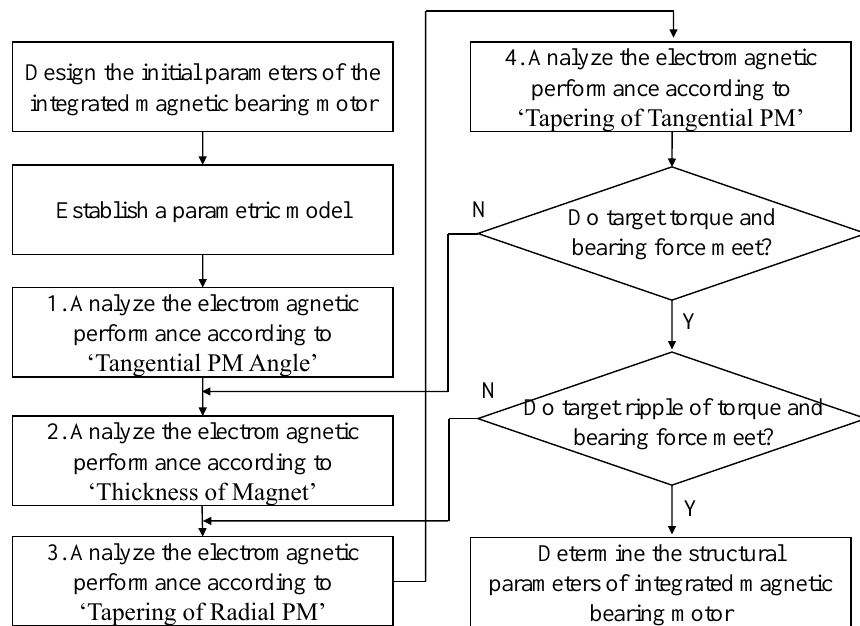
Figure 9. Flow chart for designing an integrated magnetic bearing motor.